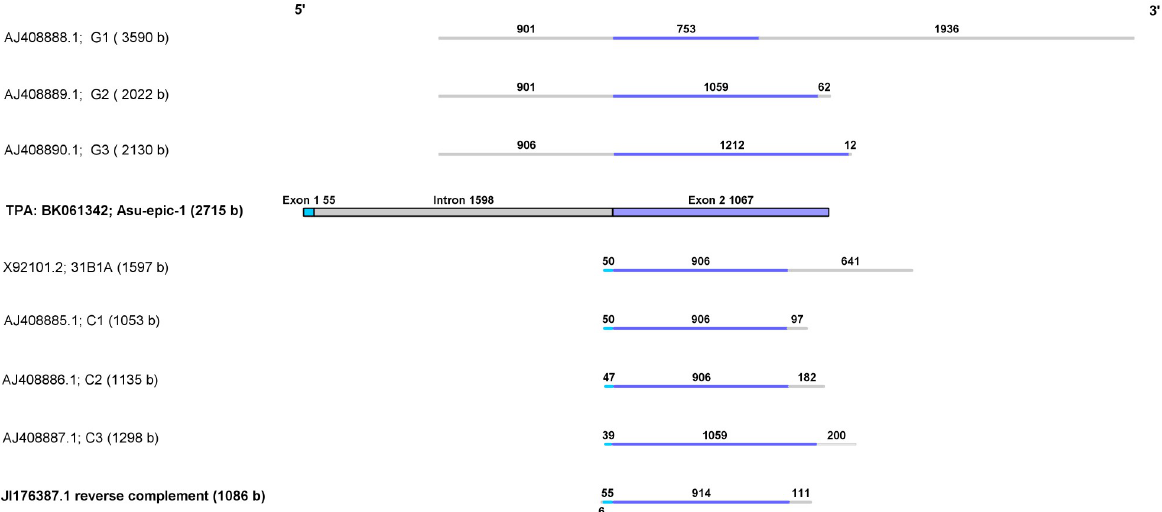
Fig 1. Sequence comparison of different Asu-epic-1 clones. Formerly characterized genomic (G) and cDNA clones (C) are aligned with the TSA sequence JI176387.1rc and the complete Asu-epic-1 gene of A . suum . Exons 1 and 2 are indicated as light and darker blue boxes or lines. The intron and untranslated regions are indicated as a gray box and gray lines with the number of nucleotides, respectively. The GenBank accession numbers, the initial designation used for the sequence submission [29, 30], and the sequence length (bases, b) are given.